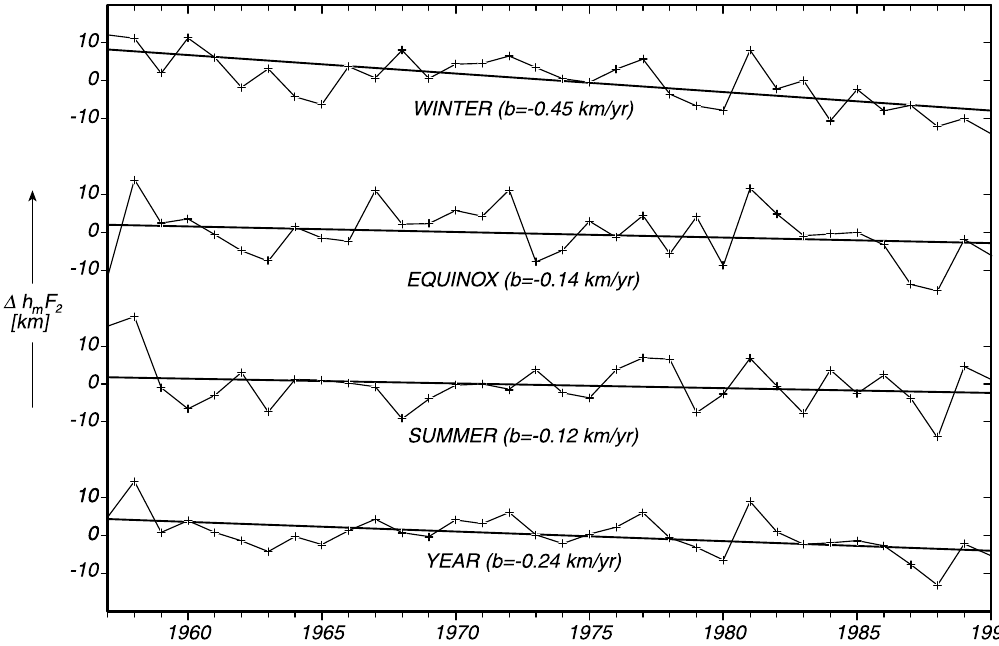
Fig. 15. Seasonal and yearly trends of h influences (Bremer, 1998)